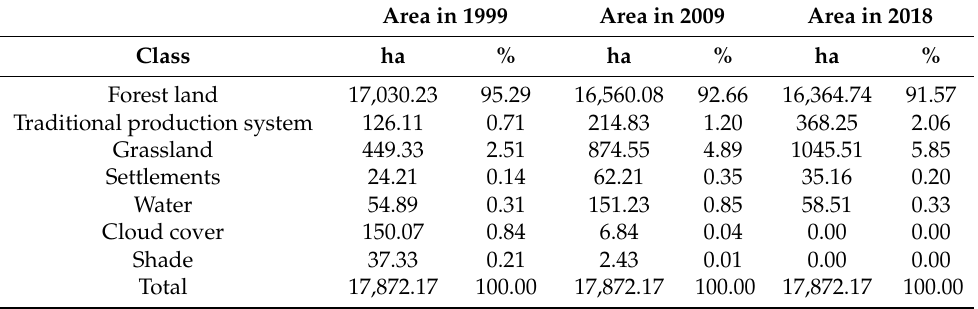
Figure 7. LULC graph for 1999, 2009, and 2018 of the DLZ’s southern zone (Inés Arango Parish) in the Yasuní Biosphere Reserve of the Ecuadorian Amazon Region. Table 6. LULC classification results for the 1999, 2009, and 2018 images, showing the area of each class and the percentages per class in the DLZ’s southern zone (In é s Arango Parish) in the Yasun í Biosphere Reserve of the Ecuadorian Amazon Region.